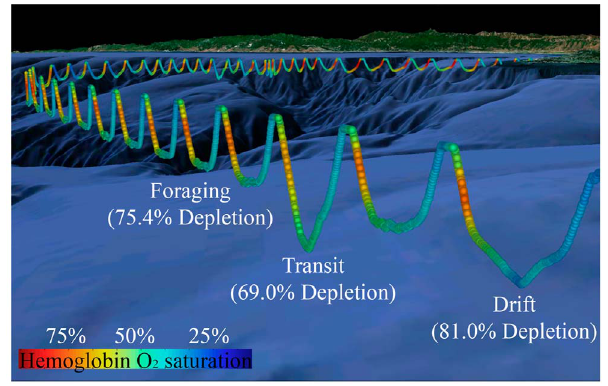
Figure 2. 3-D dive profile with corresponding % hemoglobin saturation. A 3-D series of dives with the corresponding % hemoglobin (Hb) saturation profile during each dive from Bodil (seal with electrode in hepatic sinus) as she crosses Monterey Bay [6]. Color represents % Hb O 2 saturation as indicated (S O2 decreases continuously throughout the dive, with the exception of a brief increase early in the dive. This transient increase in S vO2 is indicative of arterialized blood, continued gas exchange early in the dive, and the potential use of an arteriovenous shunt [6].) Note that O 2 is depleted to a similar extent, irrespective of dive type.